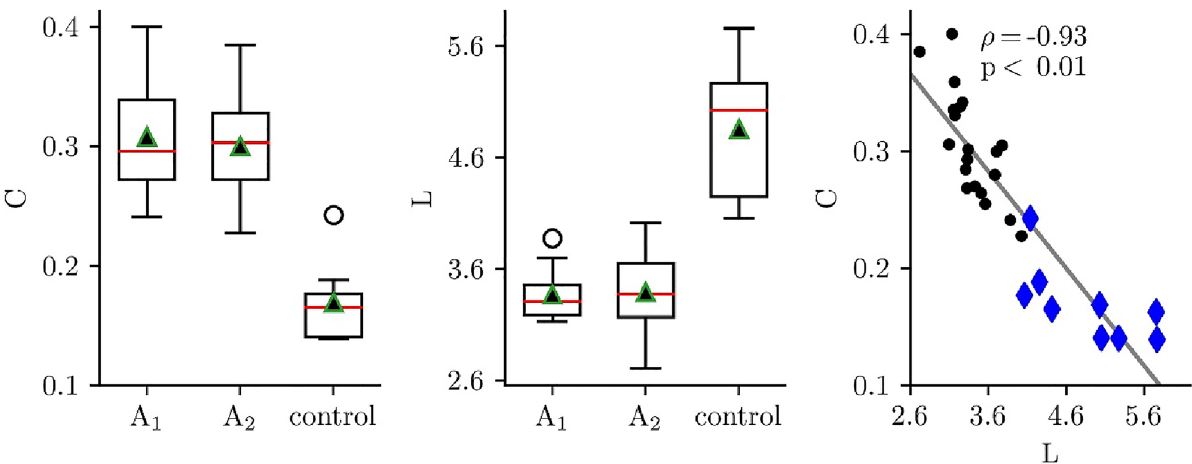
Figure 2. Sample distributions of average clustering coefficient C (left) and average shortest path length L (middle) of evolving functional brain networks from patients during period B1 at first ( A1 ) and second assessment ( A2 ) and from healthy controls. Bottom and top of a box are the first and third quartiles, and the red band and the black triangle are the median and the mean of the distribution, respectively. The ends of the whiskers represent the interquartile range of the data. Outliers are marked by an o sign. Right: Scatterplot of average clustering coefficients C and average shortest path lengths L during period B1 from patients (both assessments; black dots) and healthy controls (single assessment; blue diamonds). Linear regression (all subjects) is represented with a solid black line (patients: Spearman’s ρ = − 0.80, p < 0.01; healthy controls: ρ = − 0.88, p <